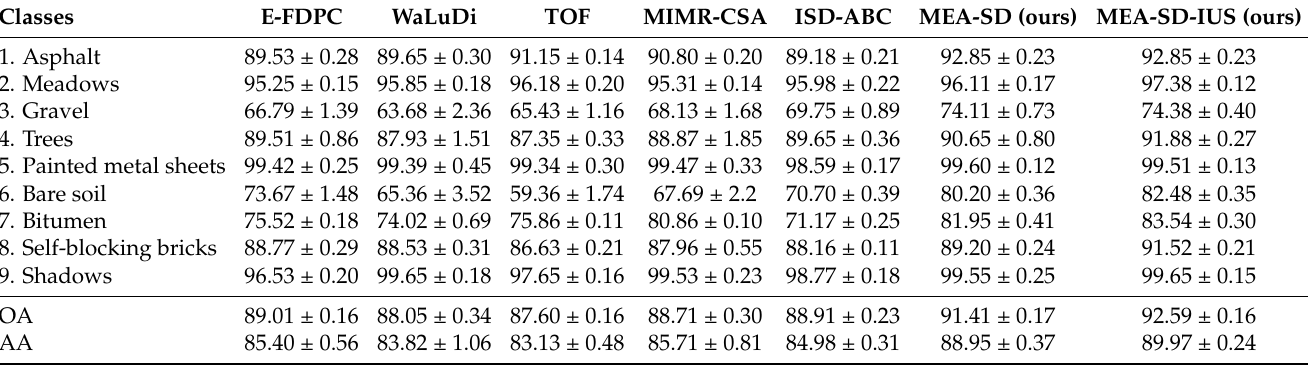
Table 6. The detailed classification accuracies (%) of different methods on Pavia University